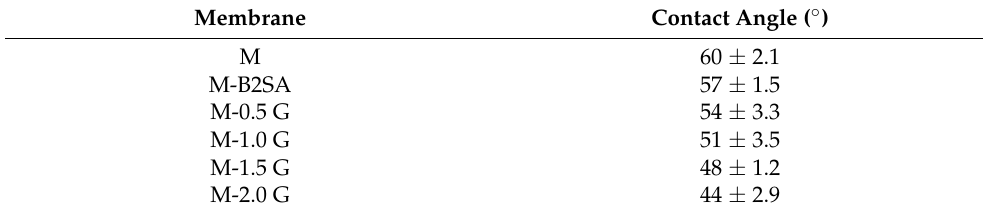
Table 2. Contact angles of the developed